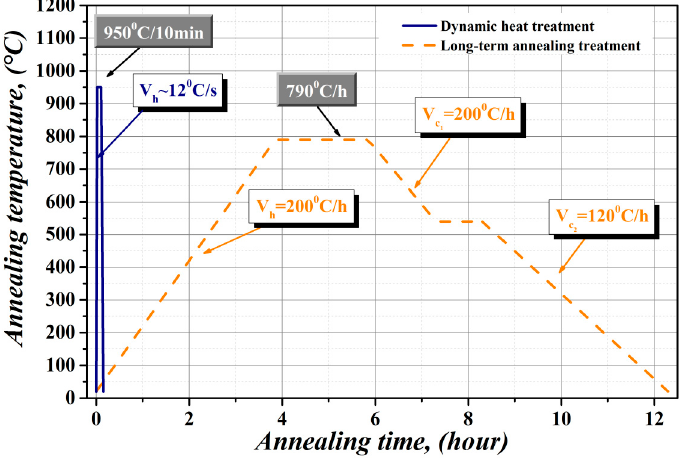
Figure 3. Schematic representation of individual heat treatment processes of experimental material: solid blue line—unconventional dynamic heat treatment of stator and rotor laminations and dashed yellow line—conventional long-term annealing treatment at industrial conditions.